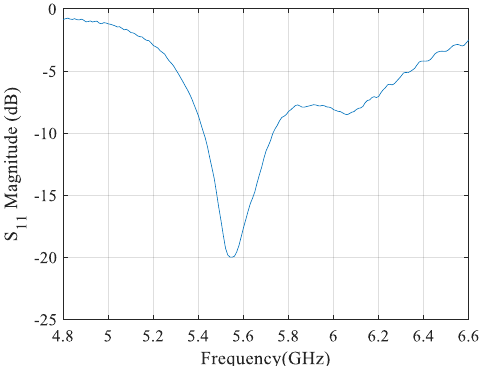
Figure 13. RF–DC converter circuit reflection coefficient magnitude measured on VNA. Figure 13. RF – DC converter circuit reflection coefficient magnitude measured on VNA.